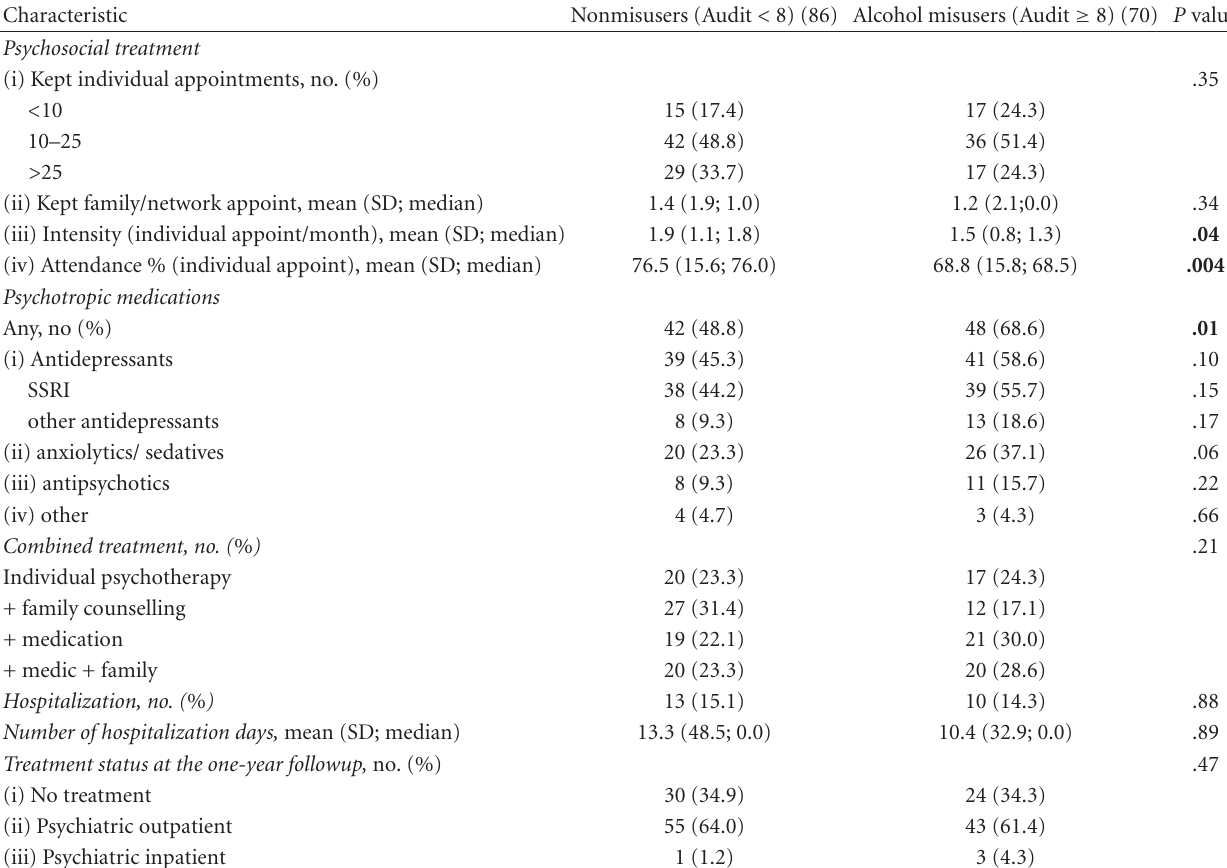
Table 2: Treatment received of depressed outpatients by alcohol use during the one-year follow-up period ( n = 156). Characteristic